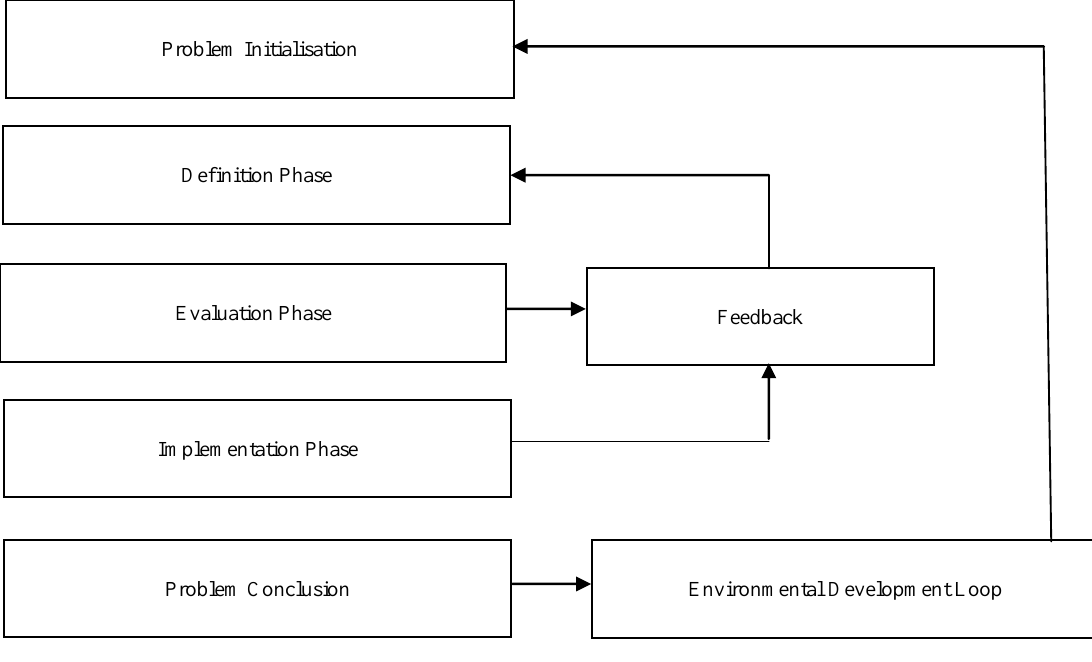
Figure 1: The basic phases of the Intervention Strategy Model